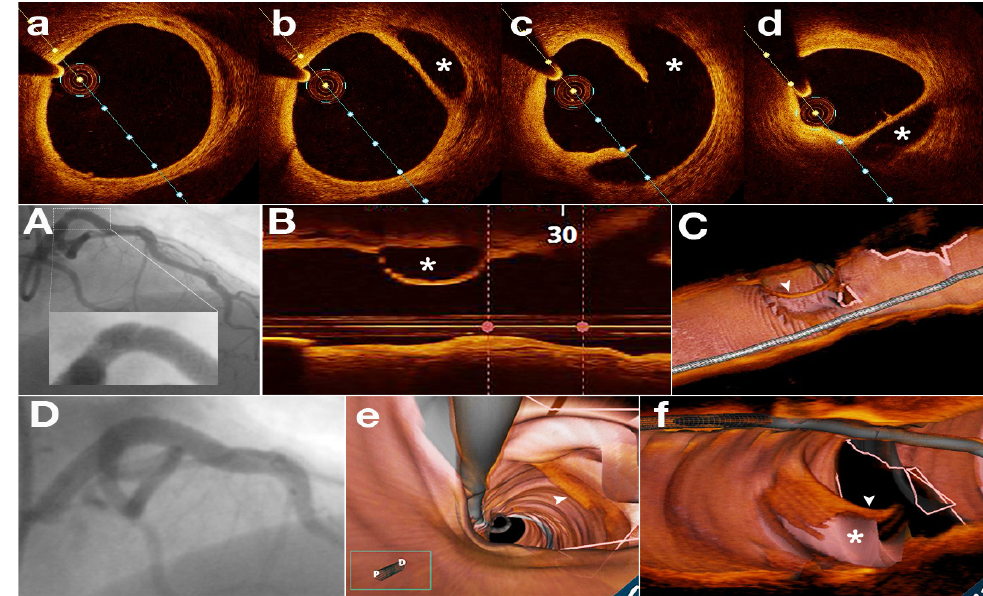
Figure 2. SCAD in a 46 years old female patient with anterior ST segment elevated myocardial in- farction. A —coronary angiography of SCAD on proximal left anterior descending artery; B —OCT—longitudinal view—SCAD—true and false lumen (asterisk); C —OCT—3D reconstruc- tion, dissection flap—white arrowhead; D —coronary angiography—post PCI result with one drug eluting stent; a – d —OCT—transversal views—SCAD—true and false lumen (asterisk); e and f —OCT—endoscopic view (dissection flap—white arrowhead, false lumen—asterisk).